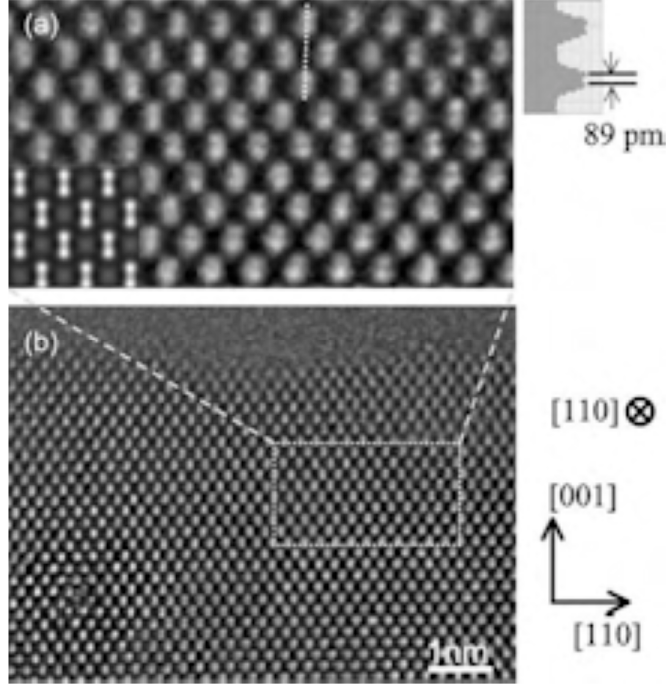
Figure 13. Aberration corrected TEM image of diamond projected along <110>. ( a ) Magnified image. ( b ) Full image. An intensity profile is shown at upper right and a simulated image is shown as an insert in ( a ). From work by Hosokawa et al. Reproduced with permission from [98]. Oxford University Press, 2013.